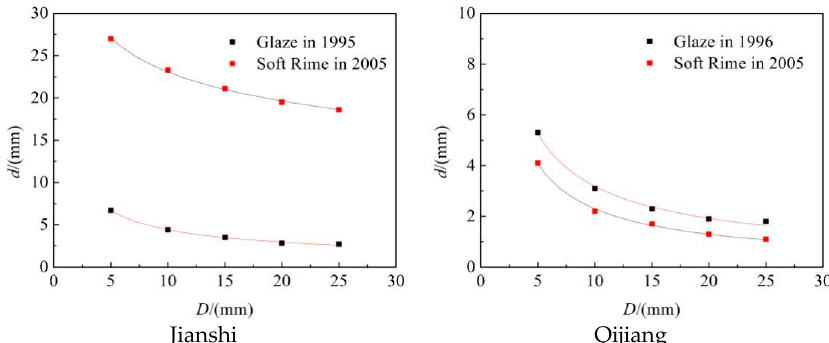
Figure 7. Fitting curves of each natural icing observation station using negative power function.